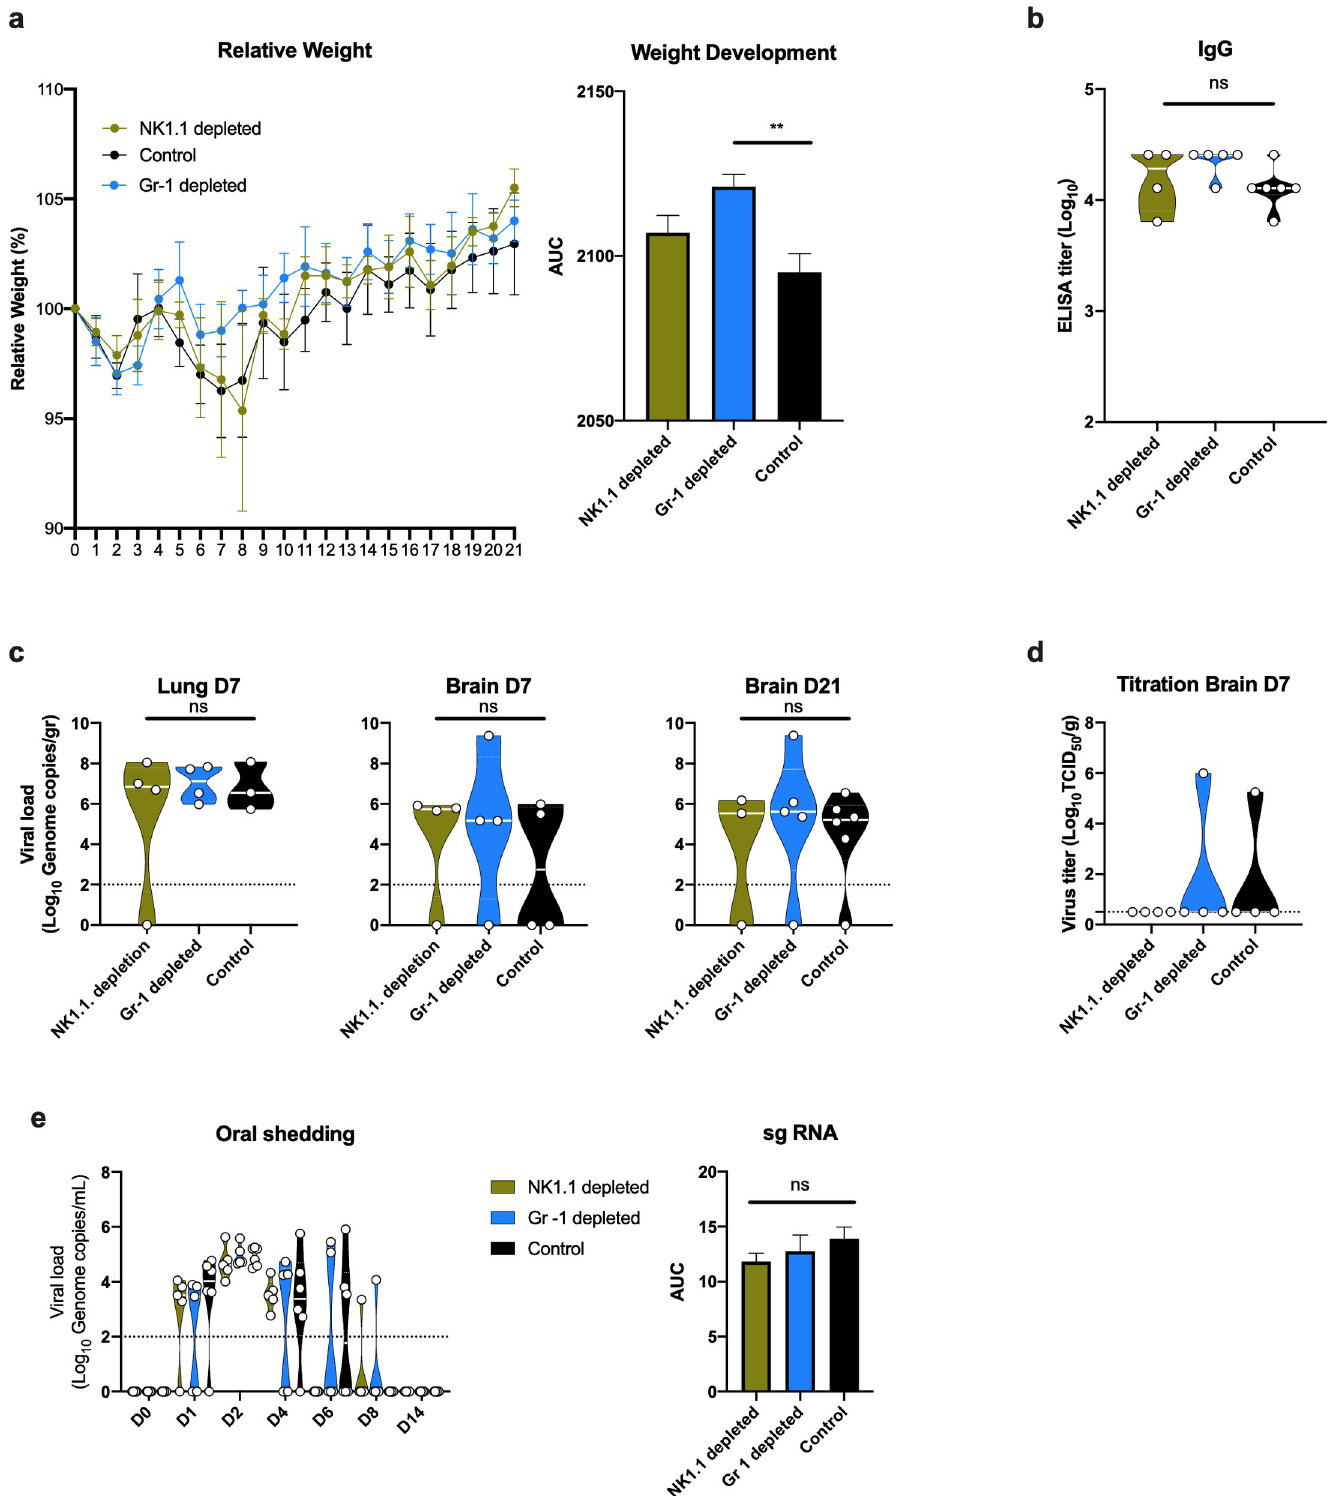
Fig 8. Effect of NK-cell and Gr-1 depletion on SARS-CoV-2 infection in K18-hACE mice. a. Relative weight loss in mice inoculated with 102 TCID50 SARS-CoV-2 after depletion of NK cells or neutrophils (Gr-1+ cells). The lines represent mean ± SEM. Area under the curve (AUC) was determined for each weight curve. b. Violin plot of IgG antibody titres against SARS-CoV-2 spike ectodomain by ELISA in serum. White line represents geometric mean of end point dilutions per study group.